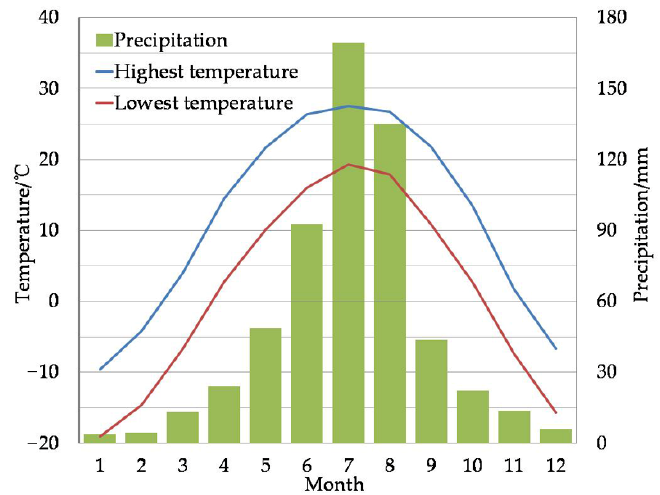
Figure 2. Temperature and precipitation in test area.